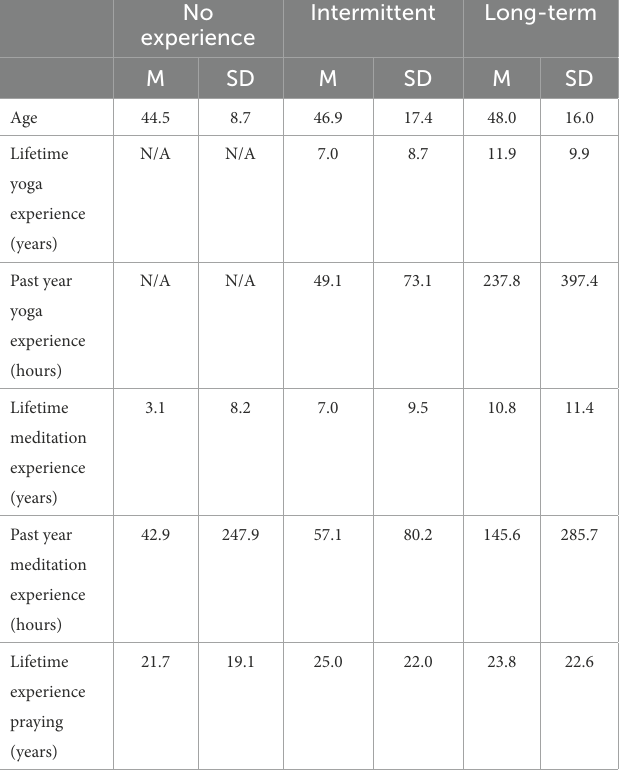
TABLE 1 Participants’ yoga, meditation, and praying experience [mean (M) and standard deviation (SD)]. No experience